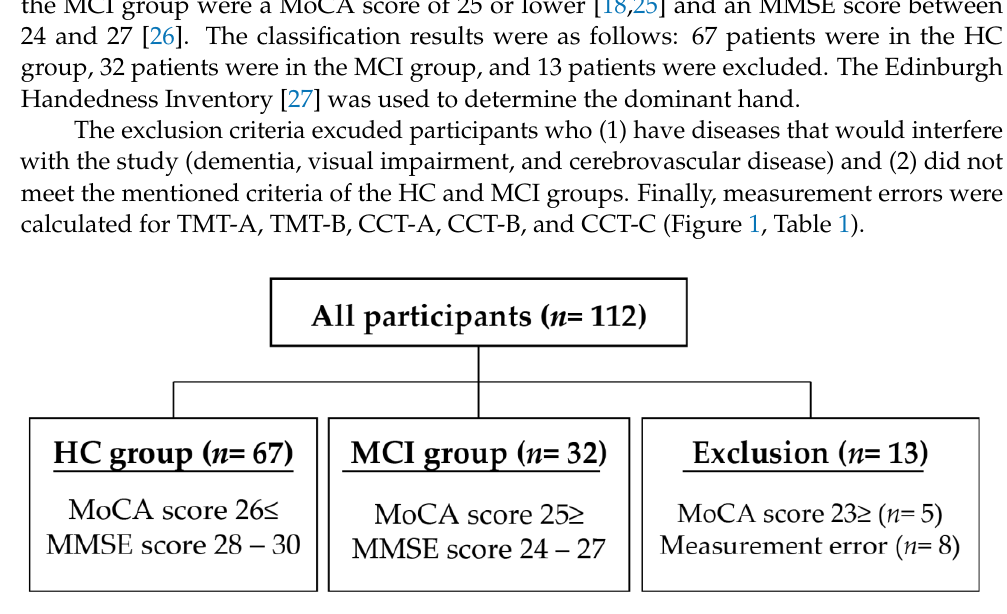
Figure 1. Classification of participants. HC Group — Healthy Control Group; MCI Group — Mild Cognitive Impairment Group; MoCA, Montreal Cognitive Assessment; MMSE, Mini-Mental State Examination. Table 1. Demographic characteristics of the